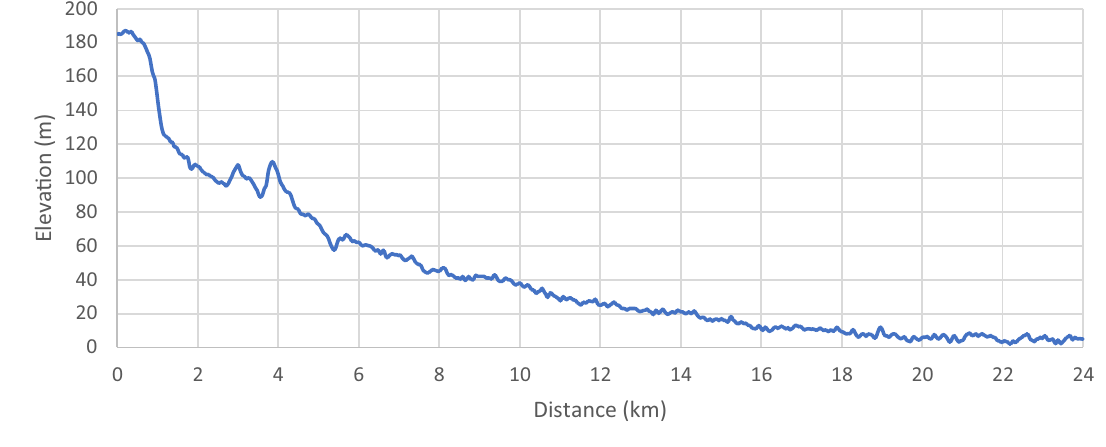
Fig. 17 North–South topographic profile of the La Teresa basin